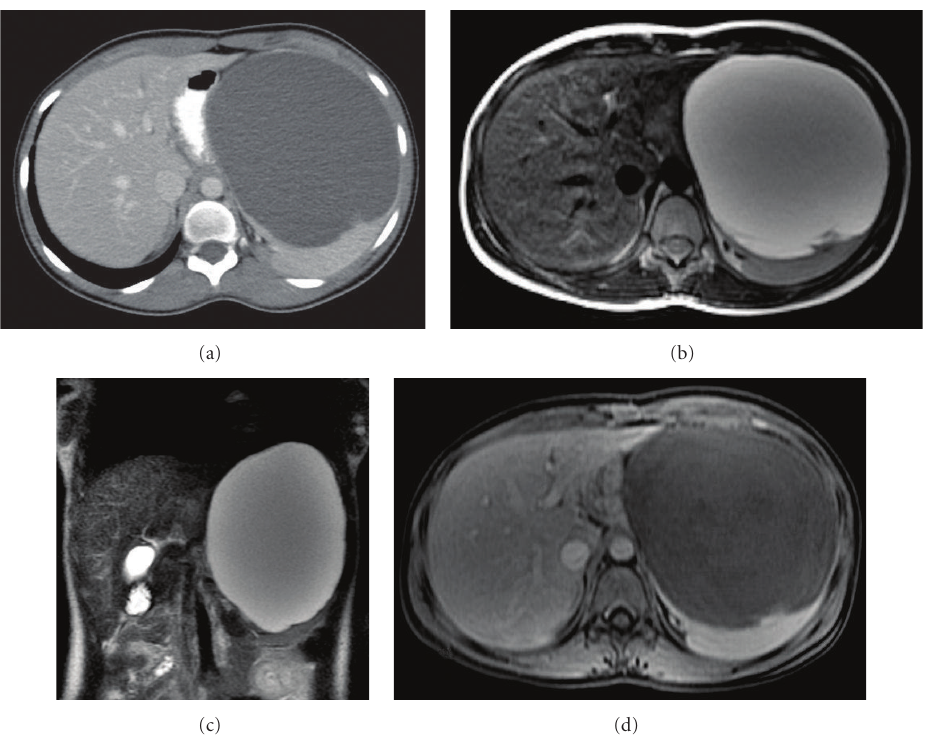
Figure 2: (a)–(d) Preoperative abdominal CT, (a) axial (b) and coronal (c) T2 weighted MRI shows a giant rounded cystic mass anterior to the spleen, which is significantly displaced posteriorly. Axial T1 weighted fat saturated MRI postgadolinium administration shows a thin peripheral enhancement of the splenic mass—possiblyrepresenting a capsule—and no internal enhancement consistent with its cystic nature (d).